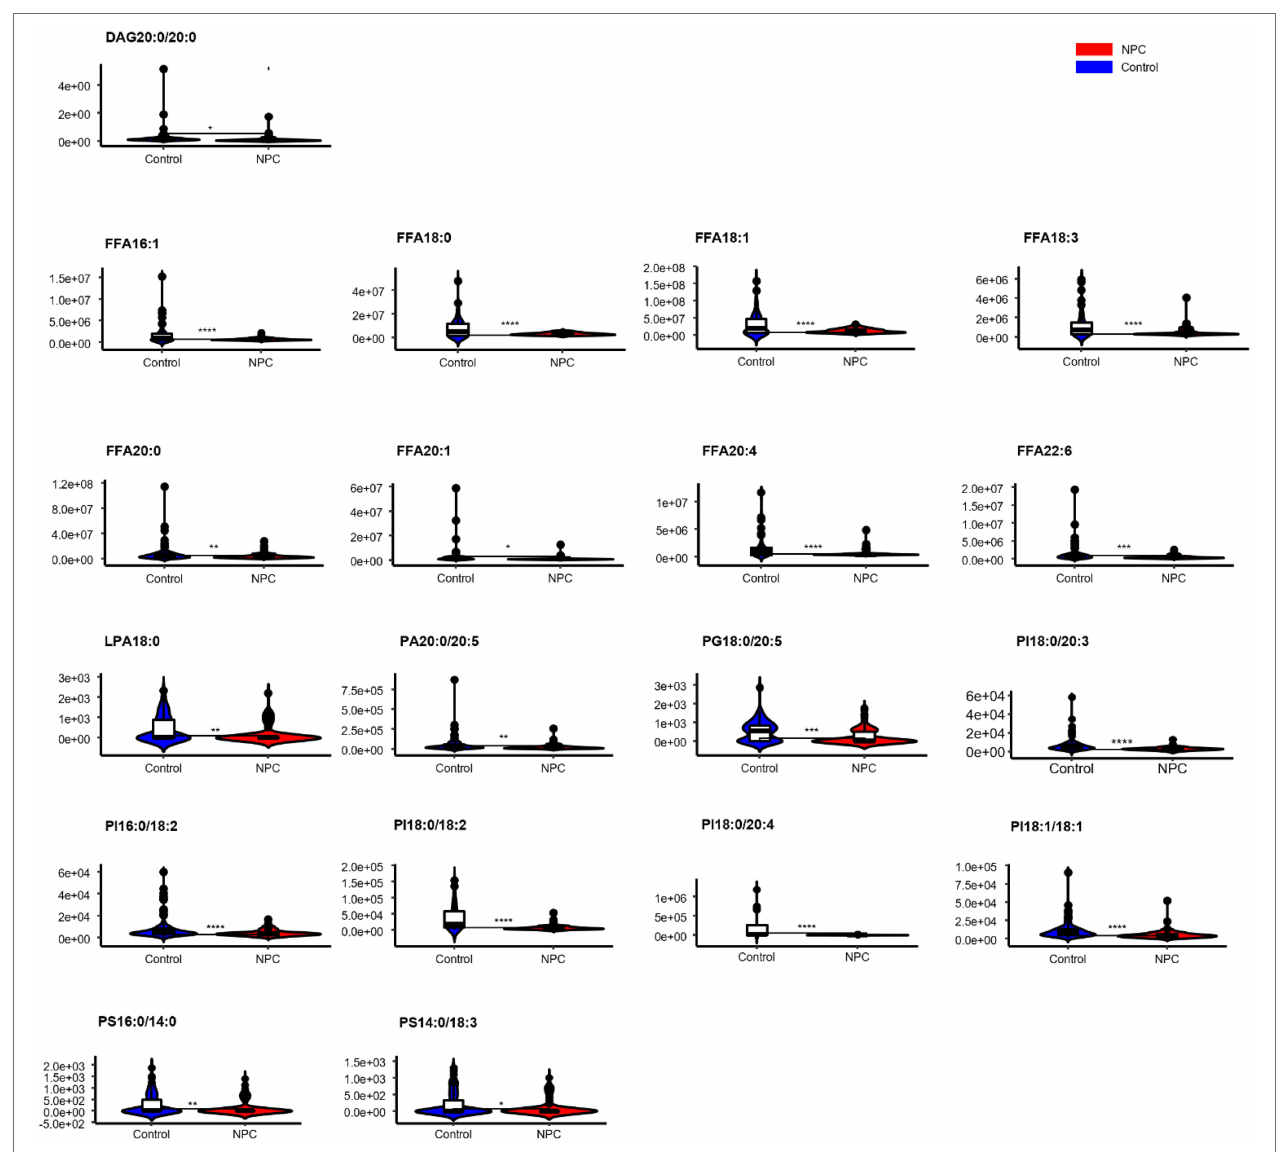
FIGURE 4 | Violin plots showing the 19 lipids with a lower level among NPC patients compared with controls. * means p < 0.05, ** means p < 0.01, *** means p < 0.001, **** means p < 0.0001, and “ns” means p > 0.05. DAG, diacylglycerol; FFA, free fatty acid; PI, phosphatidylinositol; PG, phosphatidylglycerol; PS, phosphatidylserine; PA, phosphatidic acid; LPA, lyso- phosphatidic